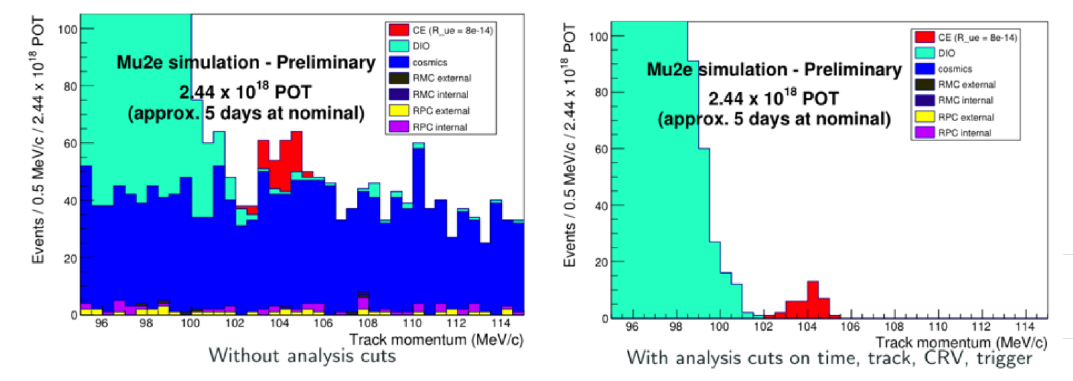
Figure 13. Momentum distribution of reconstructed electrons for a full simulation of 5 days Mu2e running. The signal in red refers to a rate for the conversion of R µ e = 8 E − 14 , i.e. 10 times smaller than current limits. Di ff erent backgrounds are represented with di ff erent colours as in the captioning: (left) for tracks without analysis cuts, (right) for tracks with analysis cuts on time, track, CRV, trigger. Mu2e data taking corresponds to around three years of run at full intensity.